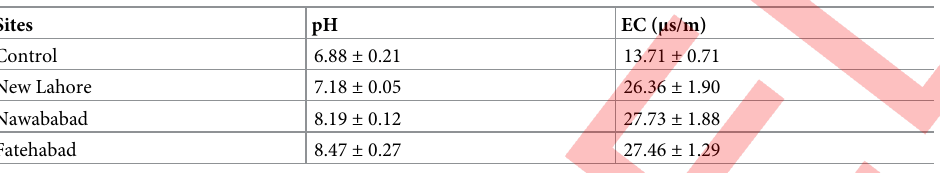
Table 2. Basic physicochemical parameters of the soil samples for selected different sites.